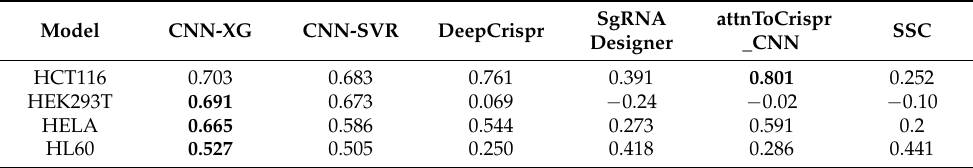
Table 6. Spearman correlations for test scenario 4.